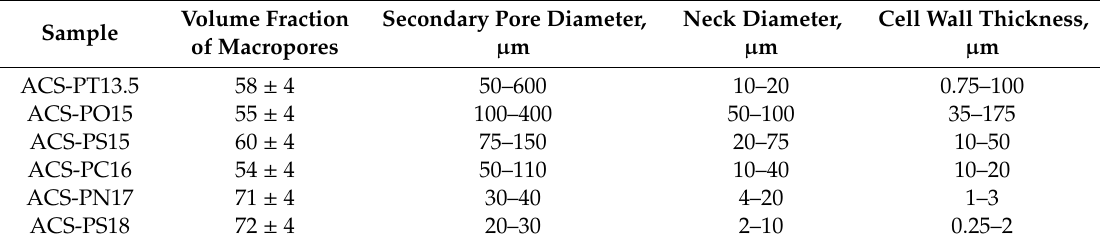
Table 2. Summary of microstructural parameters of the various dual pore cellulose materials.